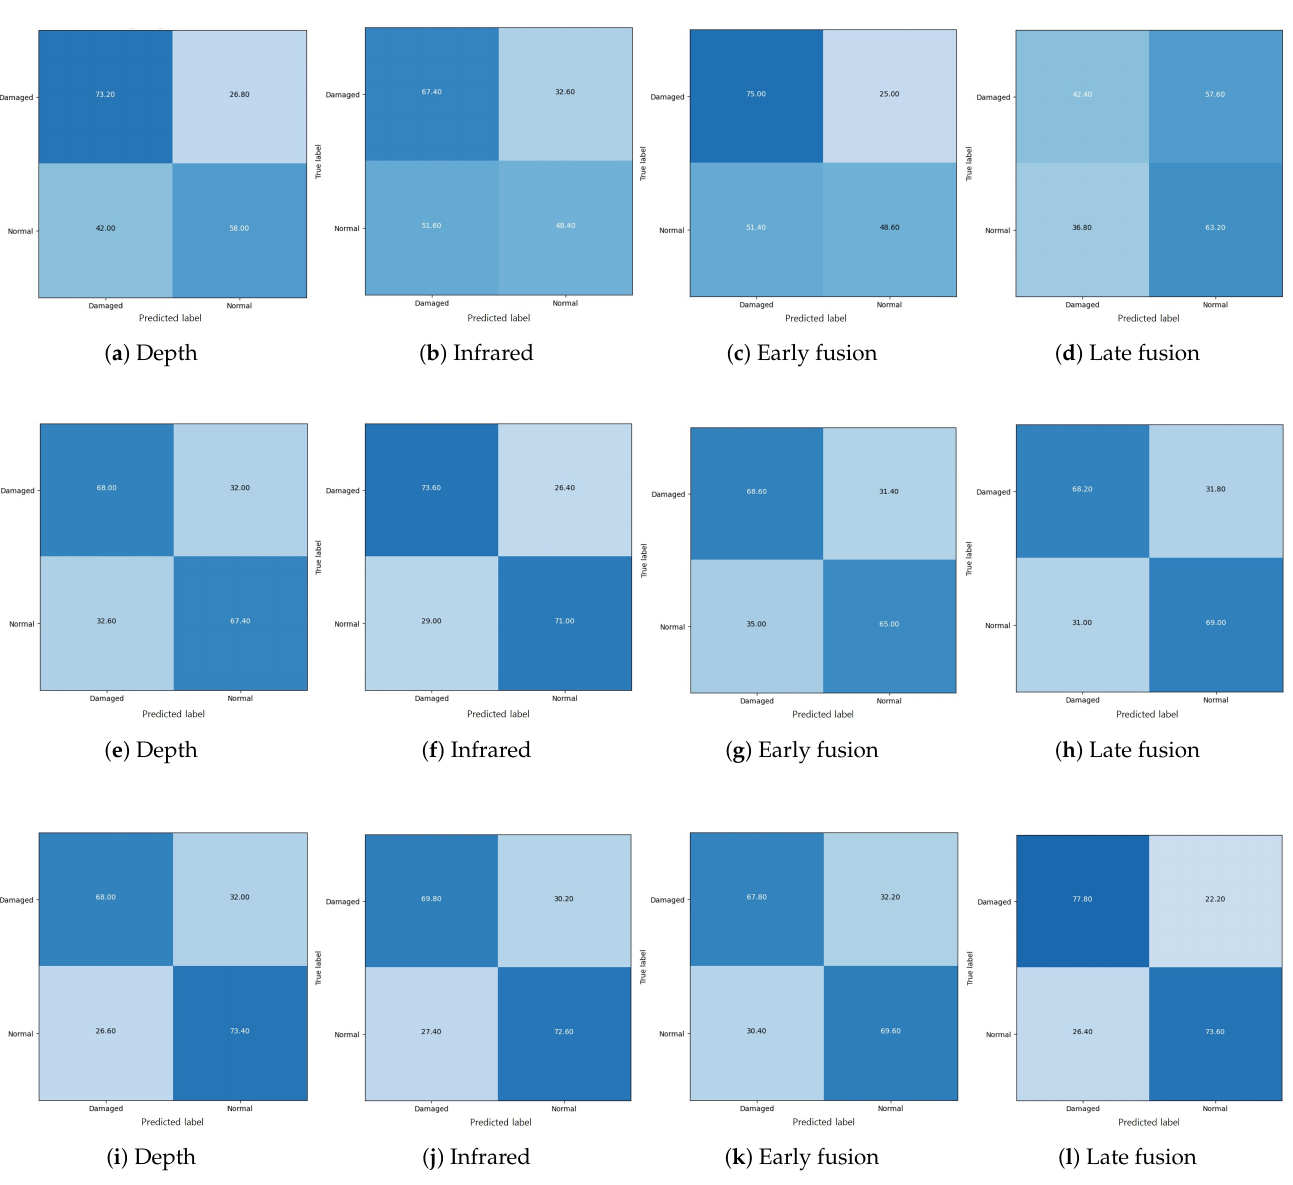
Figure A1. Confusion matrix with 100% of training data: the first, second, and third row indicate the confusion matrices from the Supervised, transfer supervised , and transfer SSL approaches,